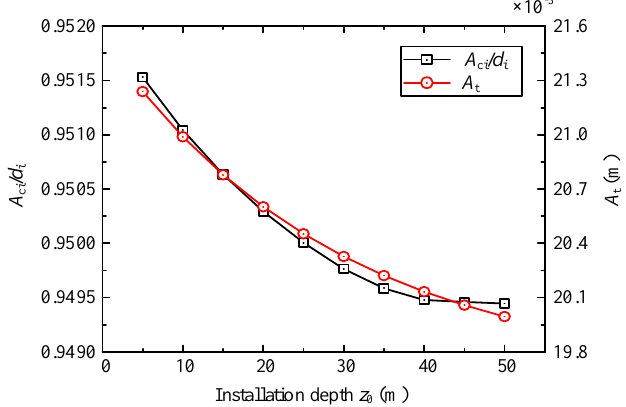
Figure 10. Structural component amplitude with different SFT installation depth (frozen parameters: v 0 = 1.18 m/s, H = 8.2 m, T = 10.8 s, GBR = 0.65, IMA = 90° and d = 190 m).